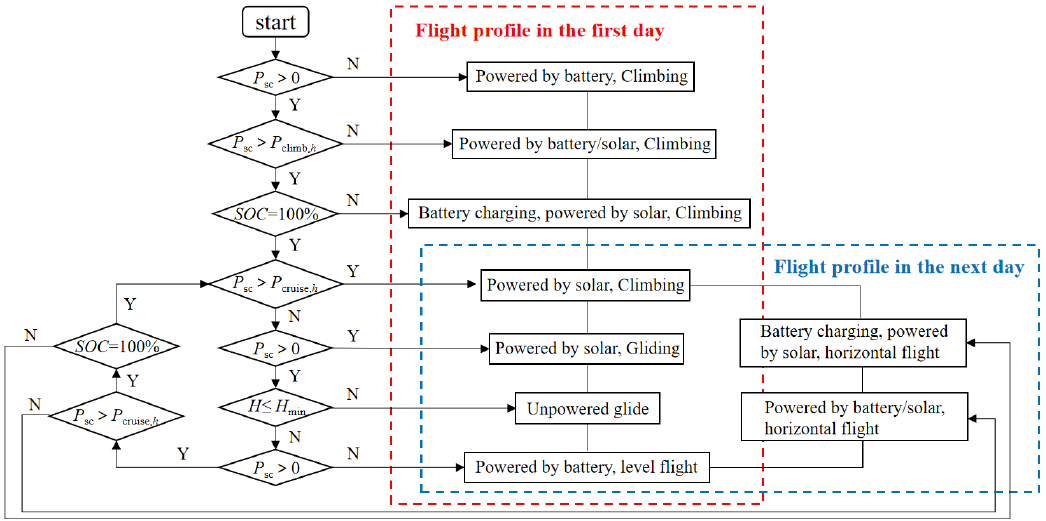
Figure 17. Control flow chart of solar-powered UAV flight strategy.